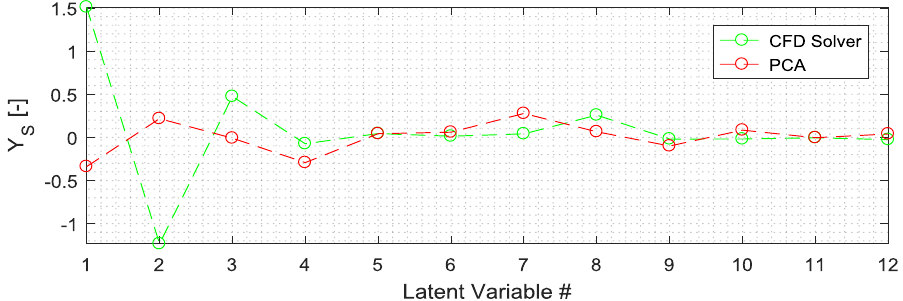
Energies 2017 , 10 , 252